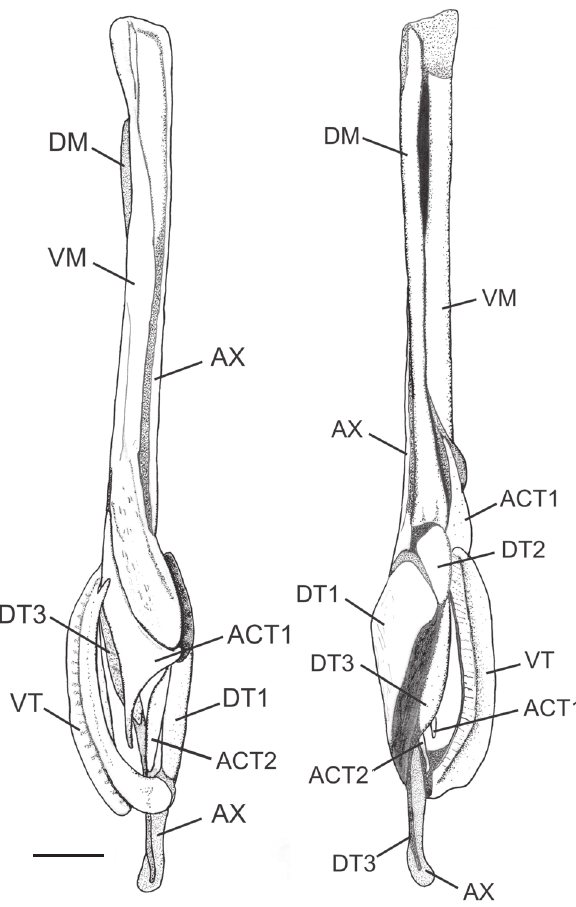
Figures 16-17. Clasper skeleton of D. mennii (UERJ 2103), in dorsal (16) and ventral (17) views. (ACT1) accessory terminal 1, (ACT2) accessory terminal 2, (AX) axial, (DM) dorsal marginal, (DT1) dorsal terminal 1, (DT2) dorsal terminal 2, (DT3) dorsal terminal 3, (VM) ventral maginal, (VT) ventral terminal. Scale bars: 16-17 = 20